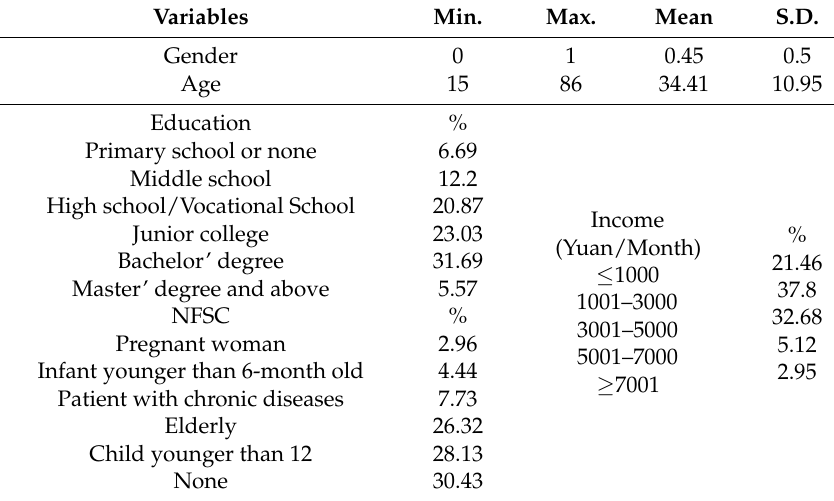
Table 1. Respondents’